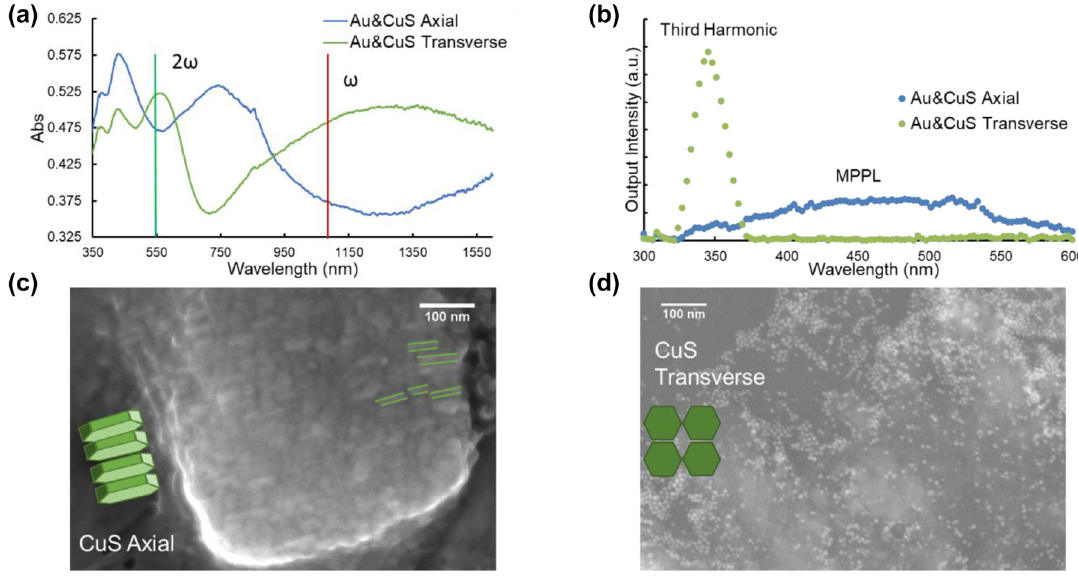
Figure 1: Effects of CuS nanodisk orientation on film absorption and upconversion mechanism. (a) UV–vis–NIR spectrophotometry of two heterostructure films deposited on glass microscope slides: Au with CuS in axial orientation (blue), Au with CuS in transverse orientation (green). (b) Spectra of output light produced by the two nanoparticle heterostructures. (c) SEM images of CuS nanoparticles with axial orientation produced by drop casting. The green lines highlight the edges of select nanodisks as a guide to the eye. (d) SEM images of CuS nanoparticles with transverse orientation produced by spin